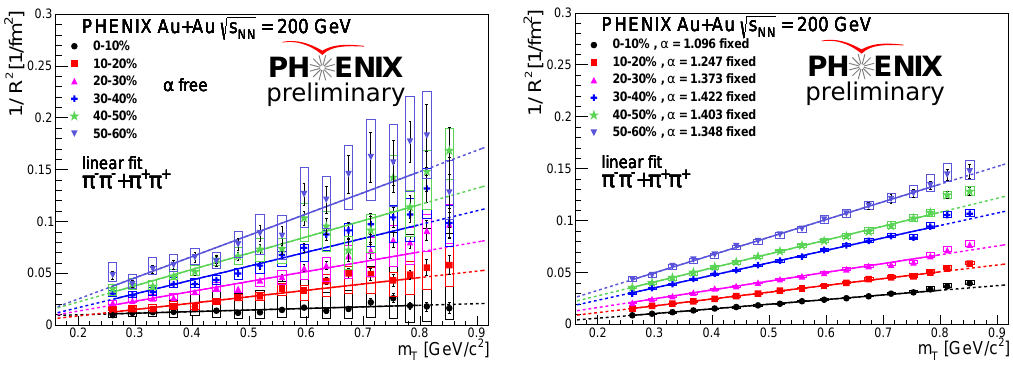
Figure 5. The hydro-type behavior of the Lévy scale parameter as a function of m T with free α ( left ) and in the case when α = (cid:104) α (cid:105) is fixed during the fit ( right ). The statistical errors are shown with errorbars and the systematical uncertainties